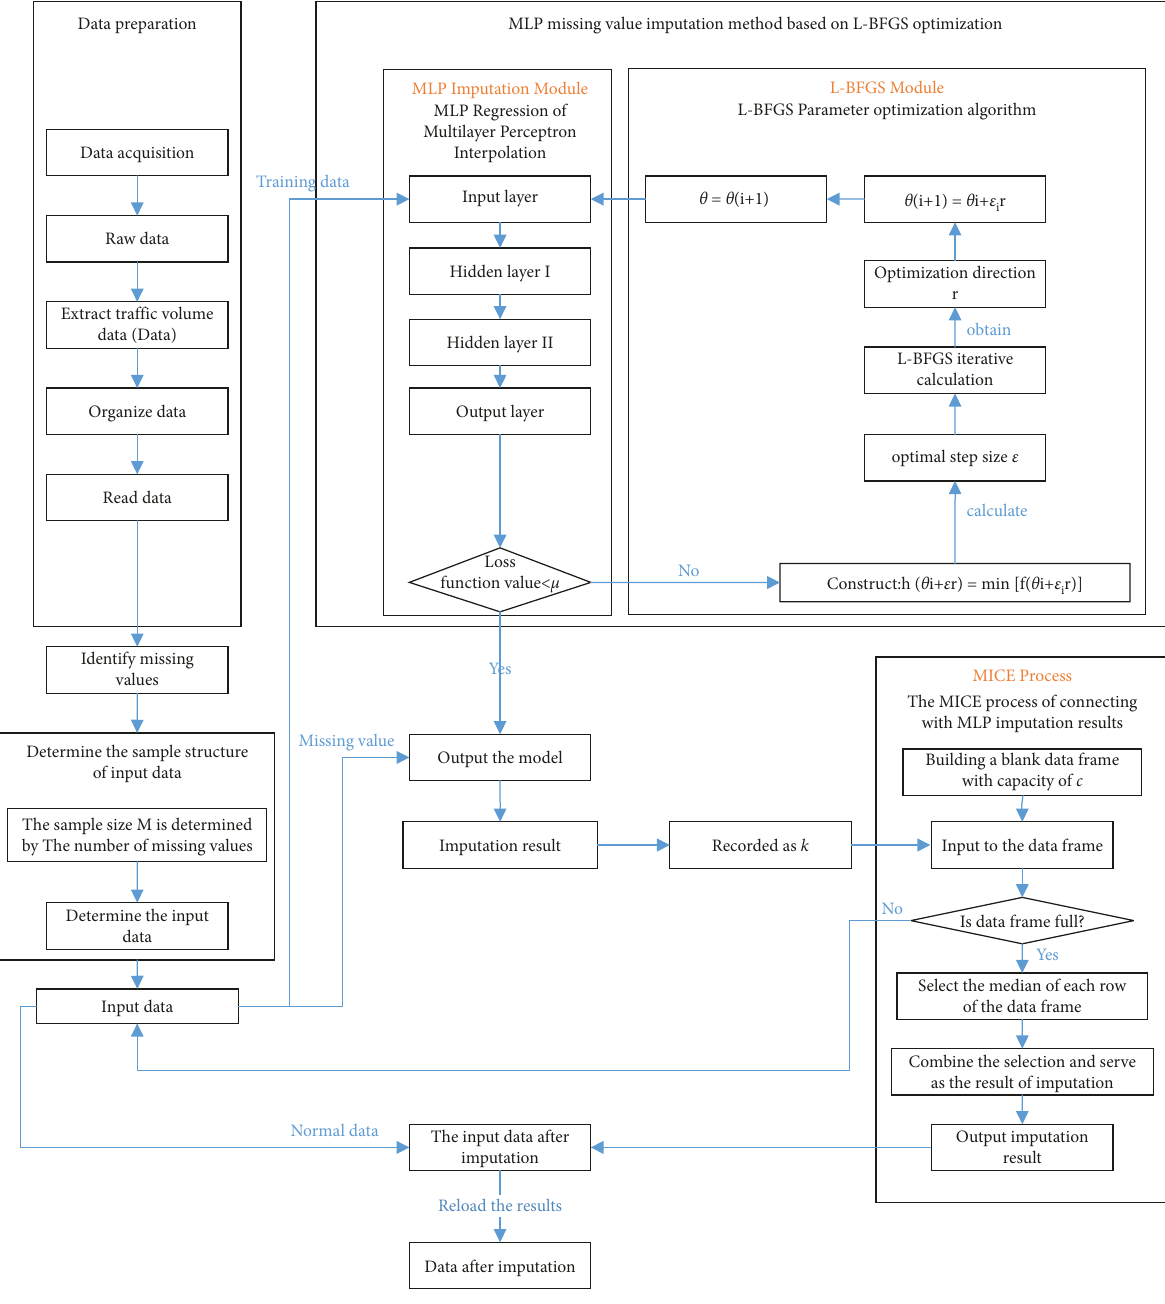
Figure 3: Flowchart of missing value imputation of the proposed